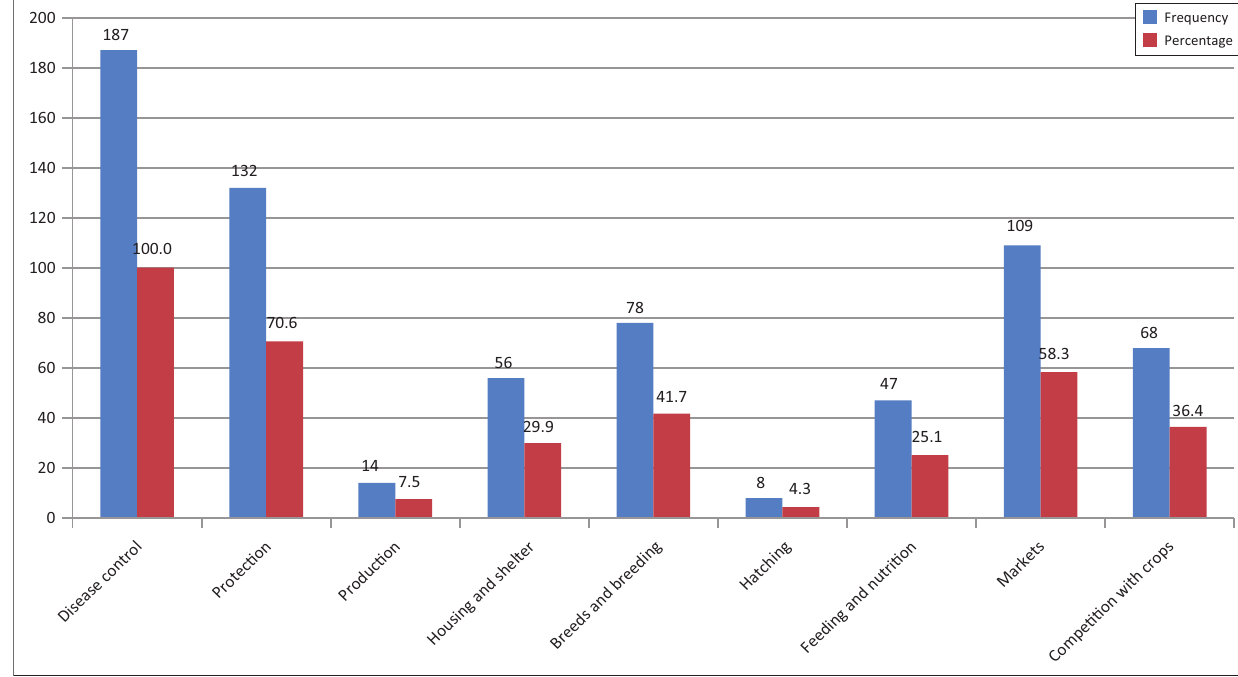
FIGURE 1: Types of information used by poultry farmers ( N =